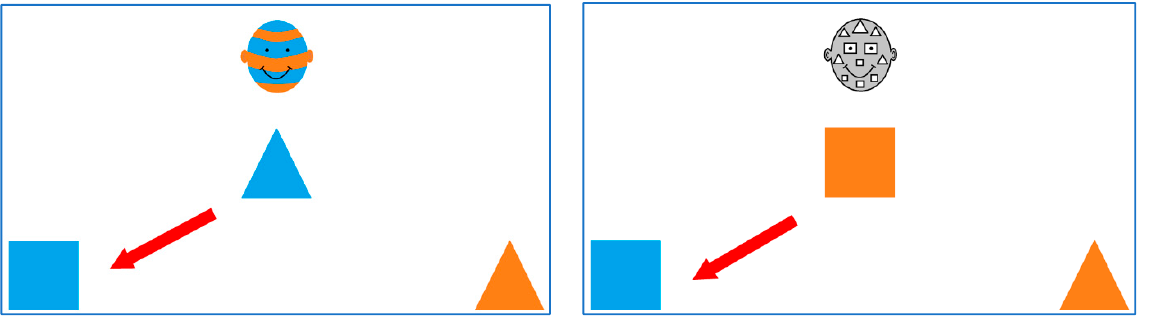
Figure 1. Example trials of the cued color/shape switching task. Note. The red arrow was presented for the purpose of instruction and was absent during the test phase.